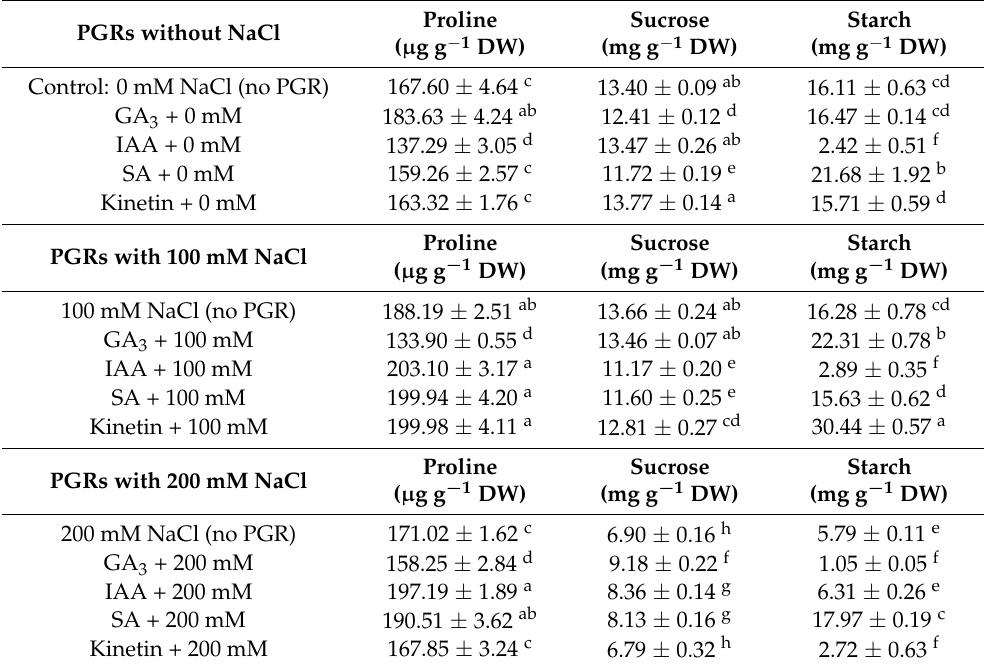
Table 4. Effect of salt stress on proline, sucrose, and starch concentrations in leaf Olea europaea plants pretreated with plant growth regulators (PGRs). Data are expressed as mean ± SE (n = 4). Proline Sucrose PGRs without NaCl ( µ g g − 1 DW) (mg g − 1 DW)